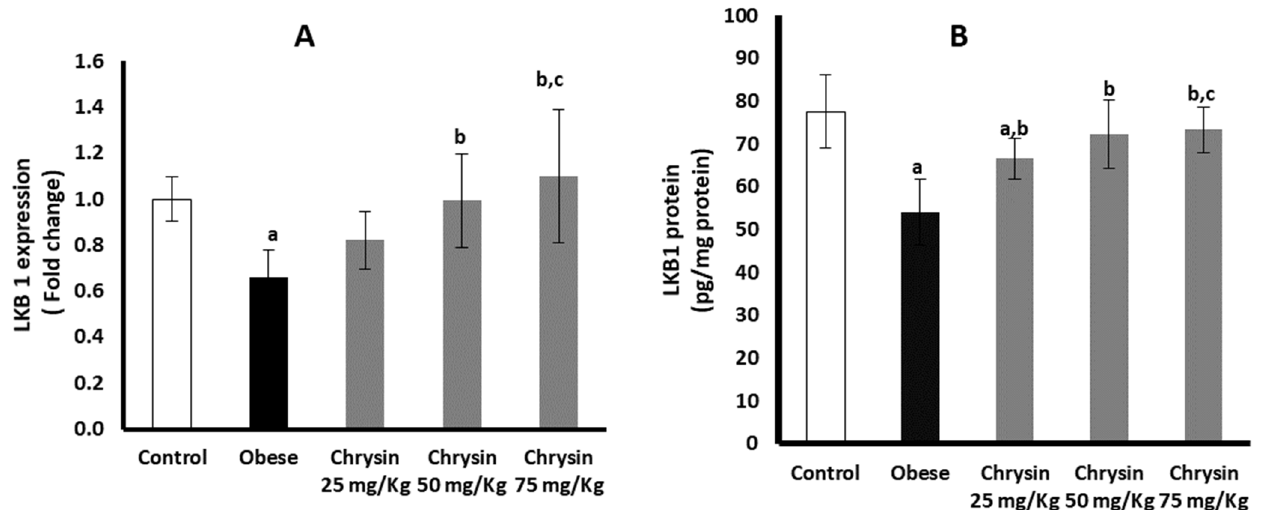
Figure 2. Changes in the hepatic expression of LKB1 at mRNA ( A ) and protein ( B ) levels in the obese rats untreated or treated with different doses of chrysin. Data presented as Mean ± SD. a, significantly different from the control group; b, significantly different from the obese group; c, significantly different from the group treated with chrysin 25 mg/kg, using ANOVA and p < 0.05.